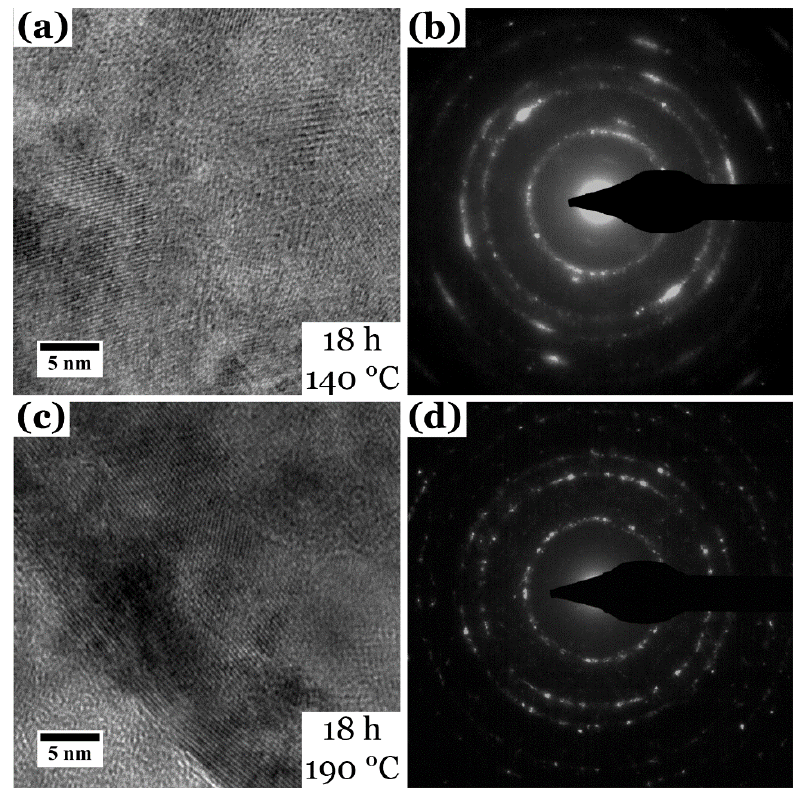
Figure 8. ( a ) HR TEM image and ( b ) corresponding electron diffraction pattern of film_140 °C. ( c ) HR TEM image and ( d ) corresponding electron diffraction pattern of film_190 °C.